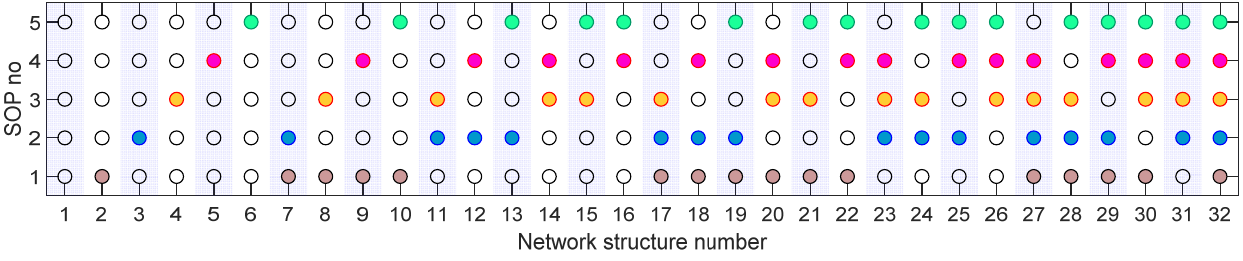
Figure 8. The button matrix of SOP combinations.